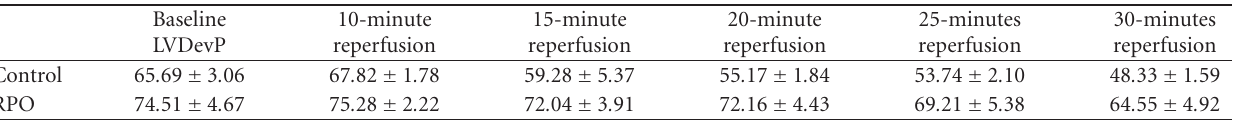
Table 1: LVDevP preischaemic baseline values and postischaemic LVDevP values for controls and RPO hearts at di ff erent reperfusion time points.